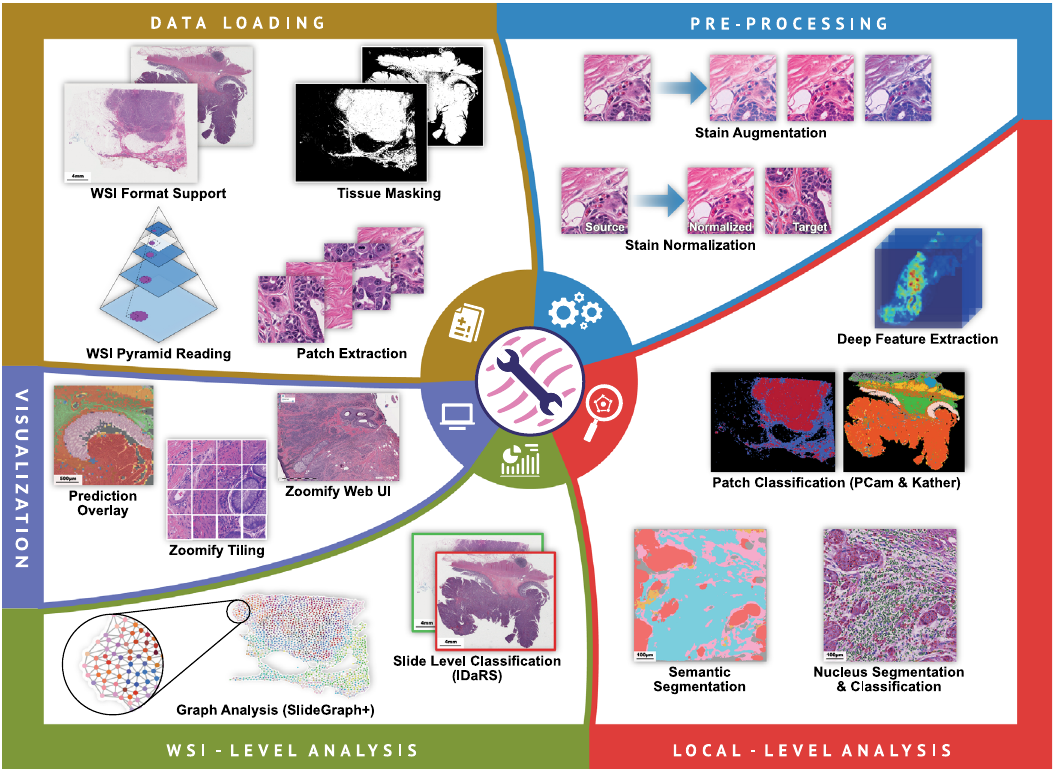
Fig. 5 An illustration of the broad range of capabilities of TIAToolbox. Capabilities of the toolbox are shown segmented into categories of data loading, pre-processing, local-level analysis, WSI-level analysis and